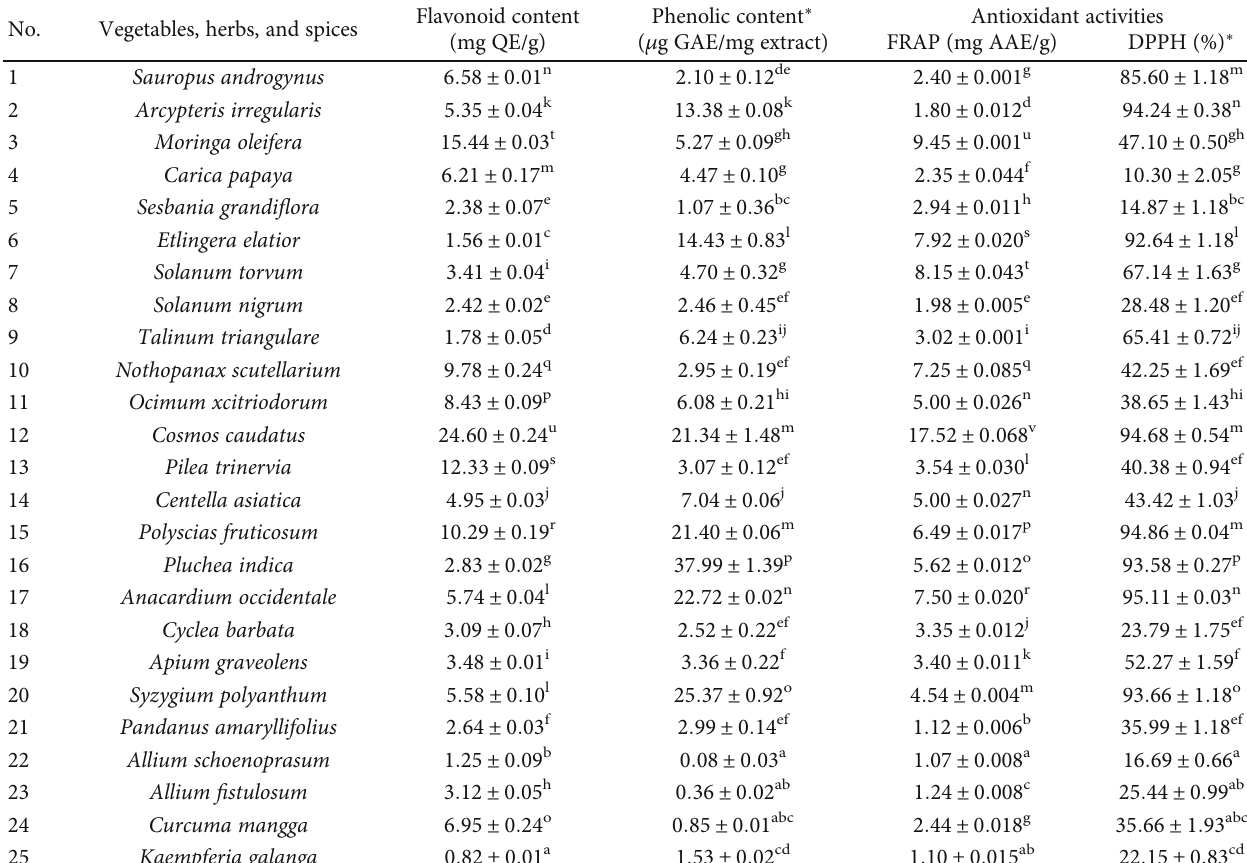
Table 2: Total fl avonoid content, phenolic content, and antioxidant activities of 25 select vegetables, herbs, and spices. No. Vegetables, herbs, and